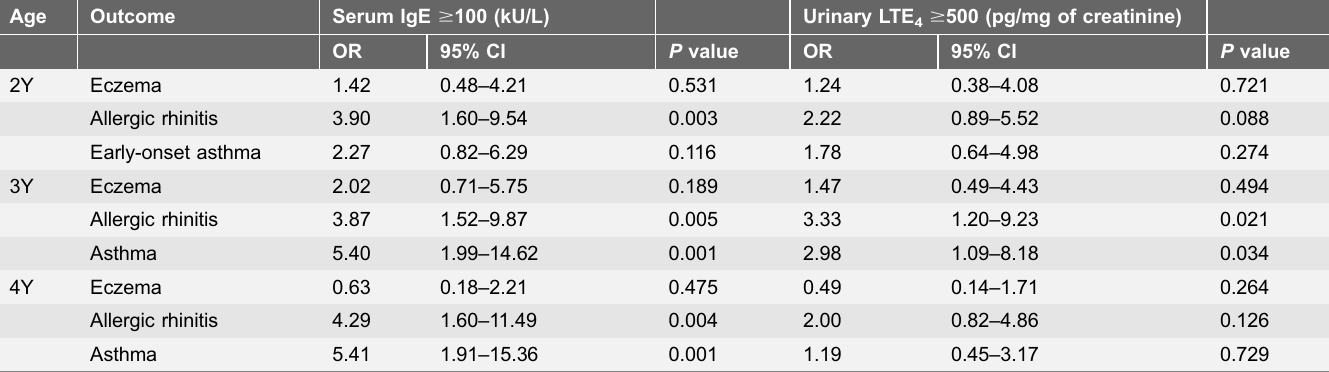
Table 1. Relationships between total serum IgE levels, urinary LTE 4 levels and risk of atopic diseases.